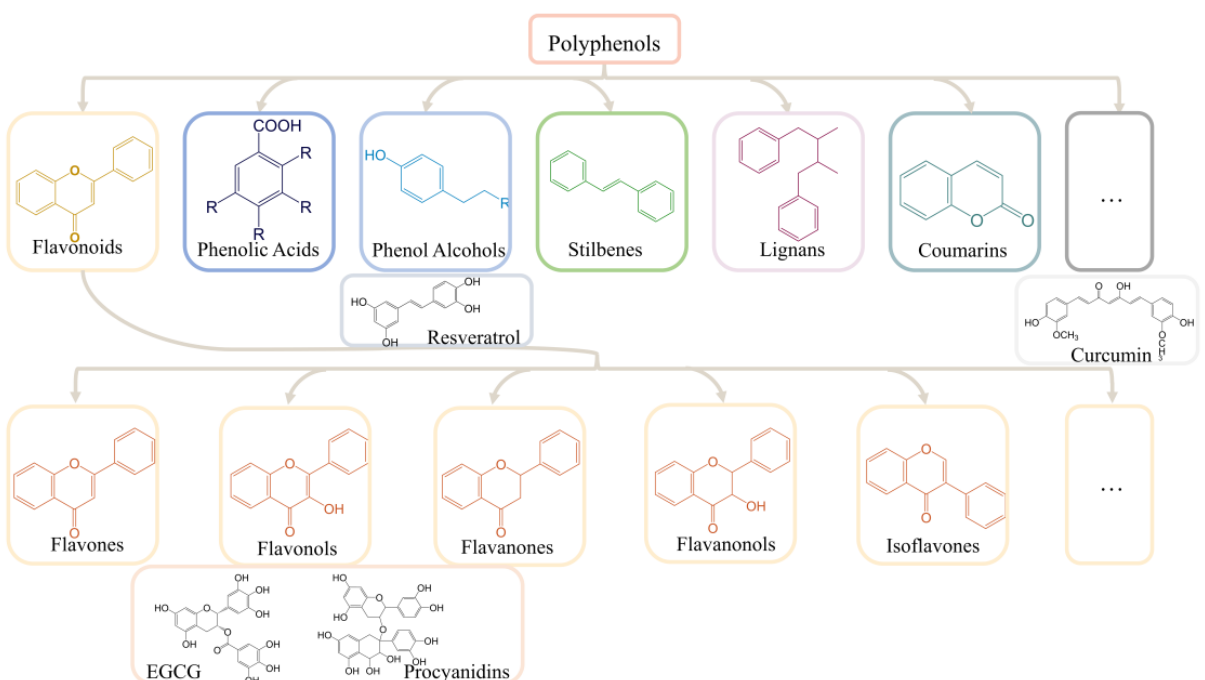
Figure 1. The classification of polyphenols. EGCG, ((−)